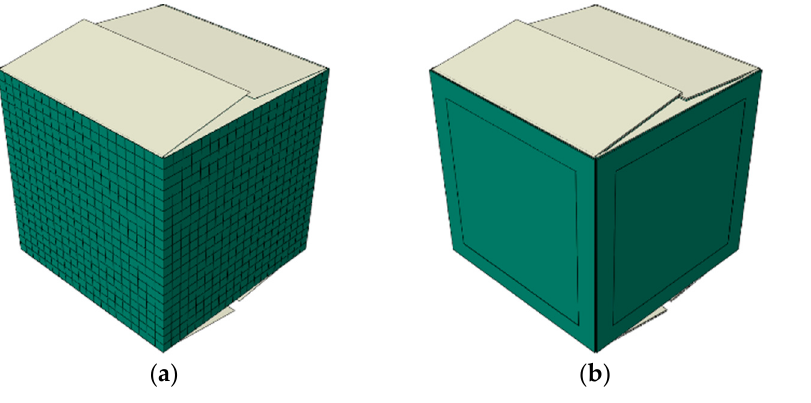
Figure 7. Numerical modelling of a box: ( a ) FE mesh, ( b ) model with two different material regions, and ( c ) model with single material region. and ( c ) model with single material